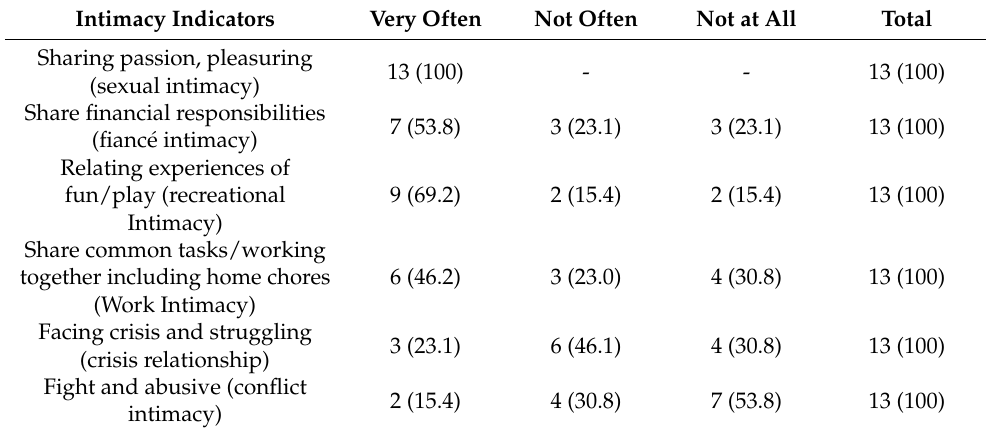
Table 2. Level of intimacy before the demise of the